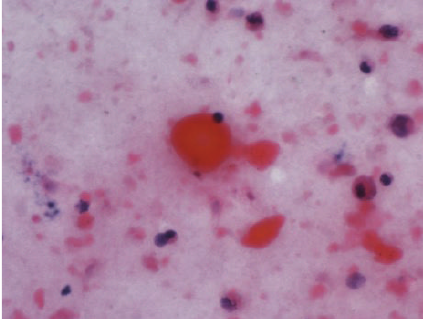
Figure 5: Papanikolaou stained BAL preparation showing abundant globular orangeophilic material along with a few macrophages and leukocytes (magnification 400x).